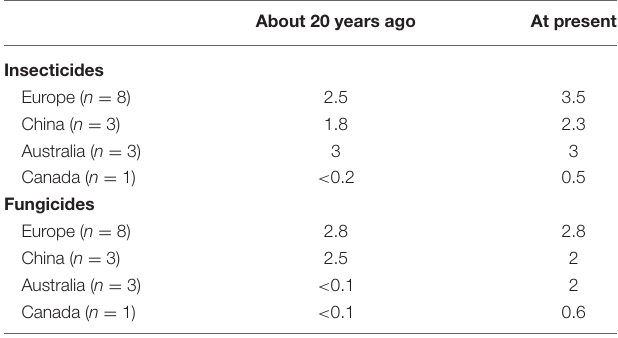
TABLE 6 | Number of active ingredients (a.i.) and modes of action (MOA) TABLE 5 | Chemical treatment frequency index (TFI a ) in oilseed rape in the past registered for use in oilseed rape in Europe from 1995 to and at present. About 20 years ago At present